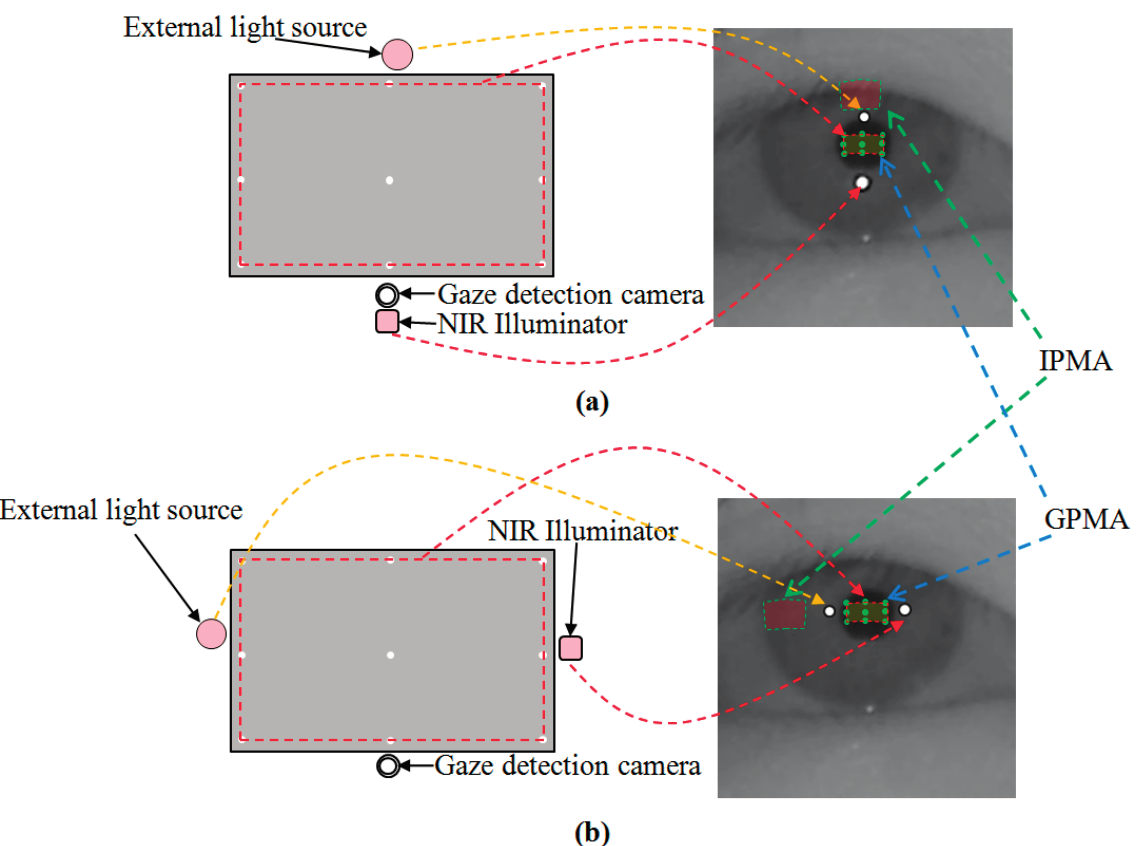
Figure 14. First scenario (external light source exists at the opposite position to the NIR illuminator based on the monitor display), and corresponding GPMA and IPMA: ( a ) External light source exists in the upper position of monitor display ( b ) External light source exists in the left position of monitor